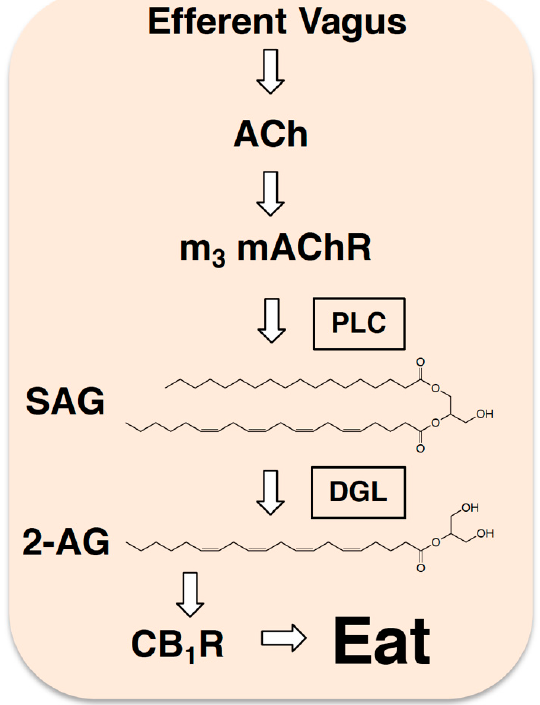
Figure 3. Efferent neurotransmission controls production of 2 ‐ AG in the gut. Studies suggest that during a fast, the efferent vagus nerve releases acetylcholine (ACh) into the lining of the small intestine, which in turn, activates local m3 ‐ subtype muscarinic acetylcholine receptors (m 3 mAChRs) that trigger production of 2 ‐ AG (see [24]). This is thought to happen by a mechanism that includes activation of phospholipase C (PLC) and generation of the diacylglycerol 2 ‐ AG pre ‐ cursor, 1, stearoyl,2 ‐ arachidonoyl ‐ sn ‐ glycerol (SAG). SAG is subsequently hydrolyzed by diacyl